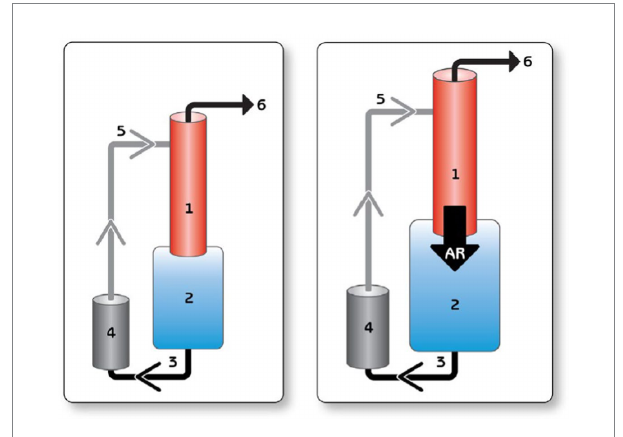
FIGURE 1 Blind circulatory loop in the setting of AR. Left, normal circuit.